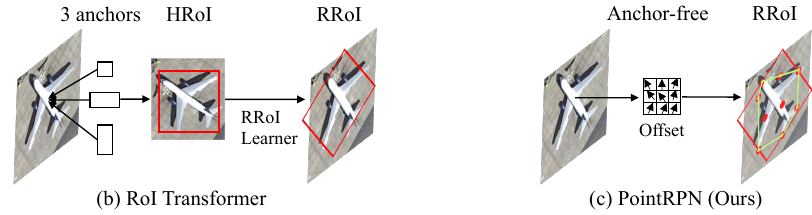
Figure 2. Comparison of different methods for generating rotated RoI (RRoI). ( a ) Rotated RPN places multiple rotated anchors with different angles, scales, and aspect ratios. ( b ) RoI transformer proposes an RRoI learner to model the RRoI from the horizontal RoI (HRoI) for each feature point based on 3 anchors. ( c ) Our proposed PointRPN generates accurate RRoI in an anchor-free and angle-free manner.